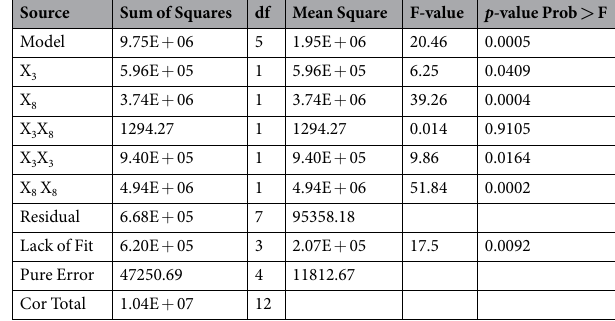
Table 5. Regression analysis of a full second-order polynomial model for optimization of nisin production. R 2 = 0.9359; Adj R 2 = 0.8902; C.V.% = 9.67; Adeq Precision =